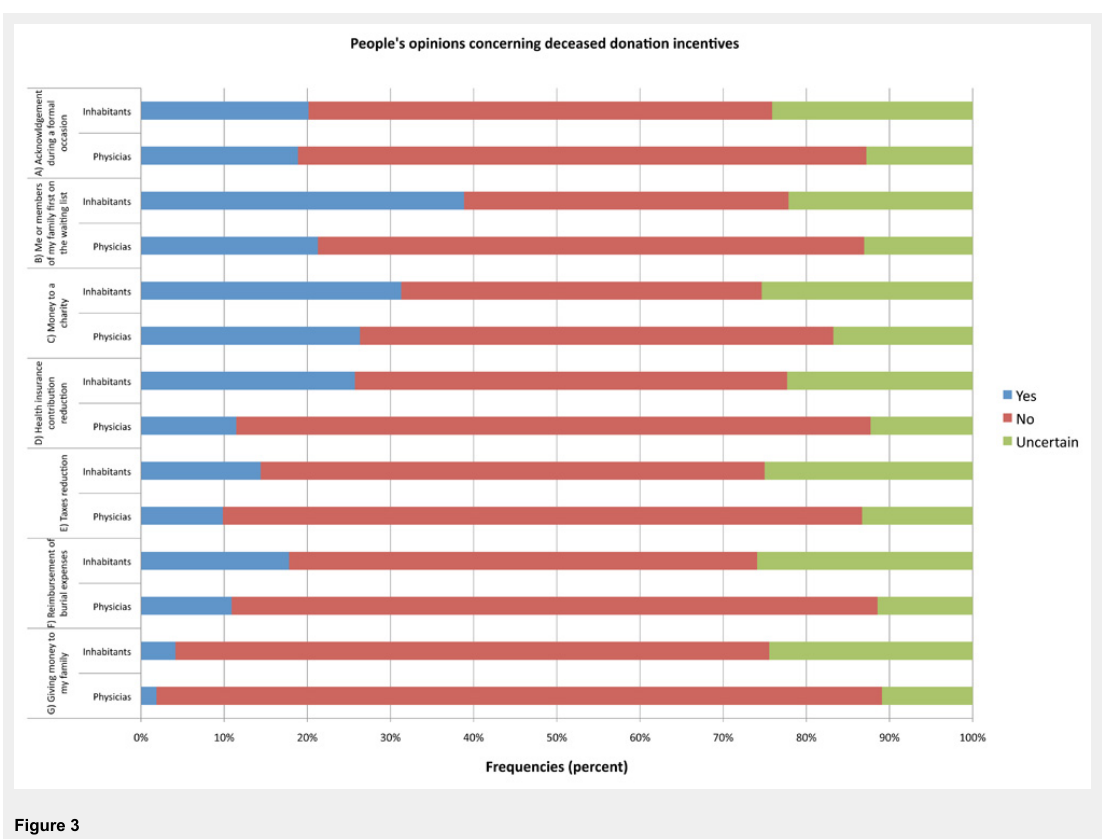
Figure 3 Distribution of the physicians’ and inhabitants’ answers to the different deceased organ donation incentive propositions.